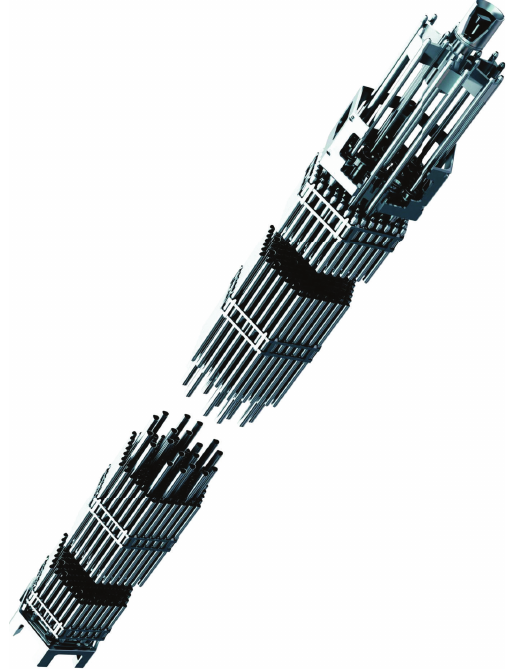
Figure 3: Fuel assembly and absorbing element.